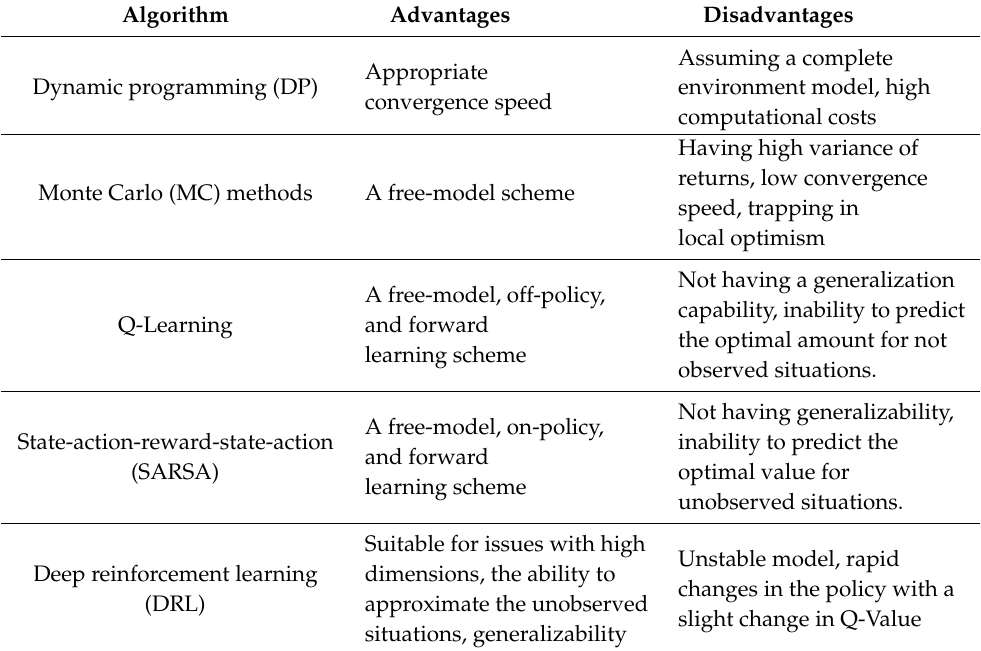
Table 6. Reinforcement learning methods and their advantages and disadvantages.